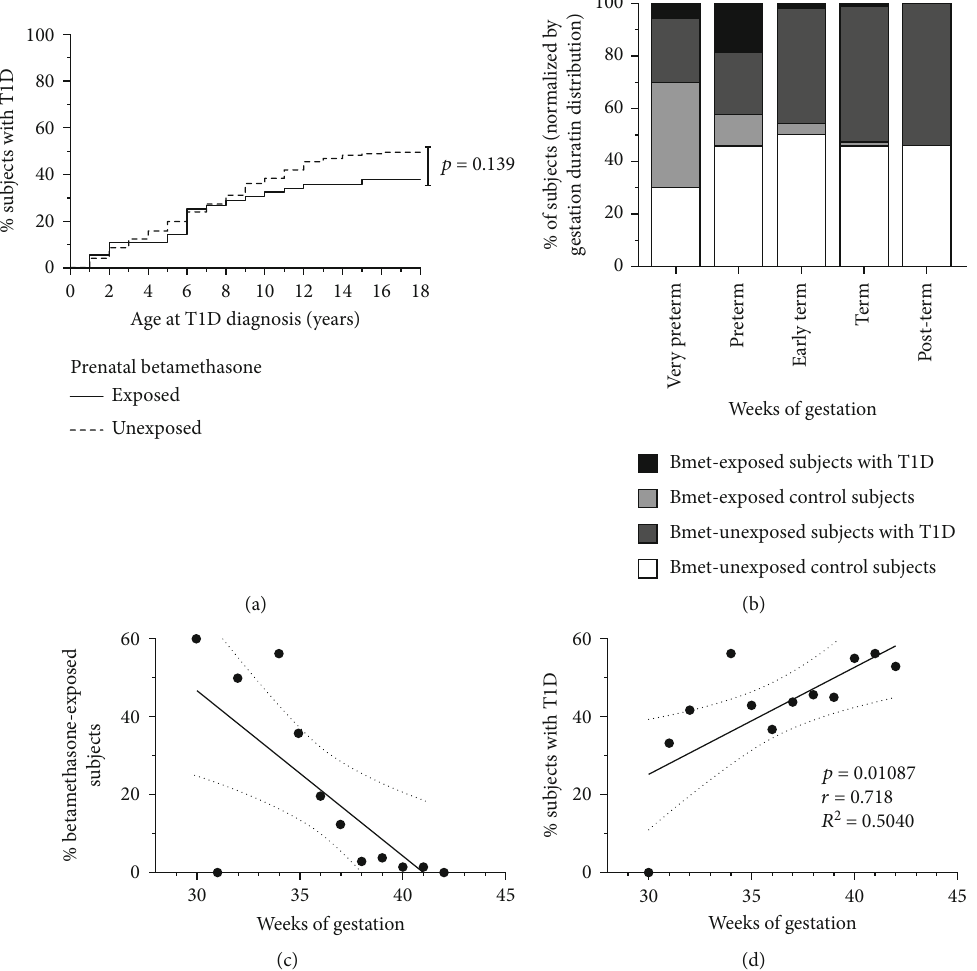
Figure 1: Prenatal betamethasone exposure tends to reduce the percentage of subjects with type 1 diabetes. (a) Percentage of subjects with type 1 diabetes (T1D) in children prenatally exposed to betamethasone (continuous line, n = 56 ) and in unexposed children (dotted line, n = 828 ). Logrank Mantel-Cox test was used for statistical analysis. (b) Percentage of children in each gestational period: very preterm (28 – 32 week gestational age (GA), n = 20 ); preterm (33 – 36week GA, n = 72 ); early term (37 – 38 week GA, n = 248 ); term (week 39 – 41 GA, n = 470 ); postterm ( ≥ 42 week GA, n = 50 ). White bars represent the percentage of the betamethasone-unexposed (Bmet-unexposed) control subjects; light grey bars represent the percentage of betamethasone-exposed (Bmet-exposed) control subjects; dark grey bars represent the percentage of Bmet-unexposed subjects with T1D; and black bars represent the percentage of Bmet-exposed subjects with T1D. All percentages were calculated with respect to the total number of subjects in each gestational period. (c) Percentages of children prenatally exposed to betamethasone in relation to weeks of gestation. (d) Correlation between the percentages of children with T1D and weeks of gestation (Spearman ’ s correlation